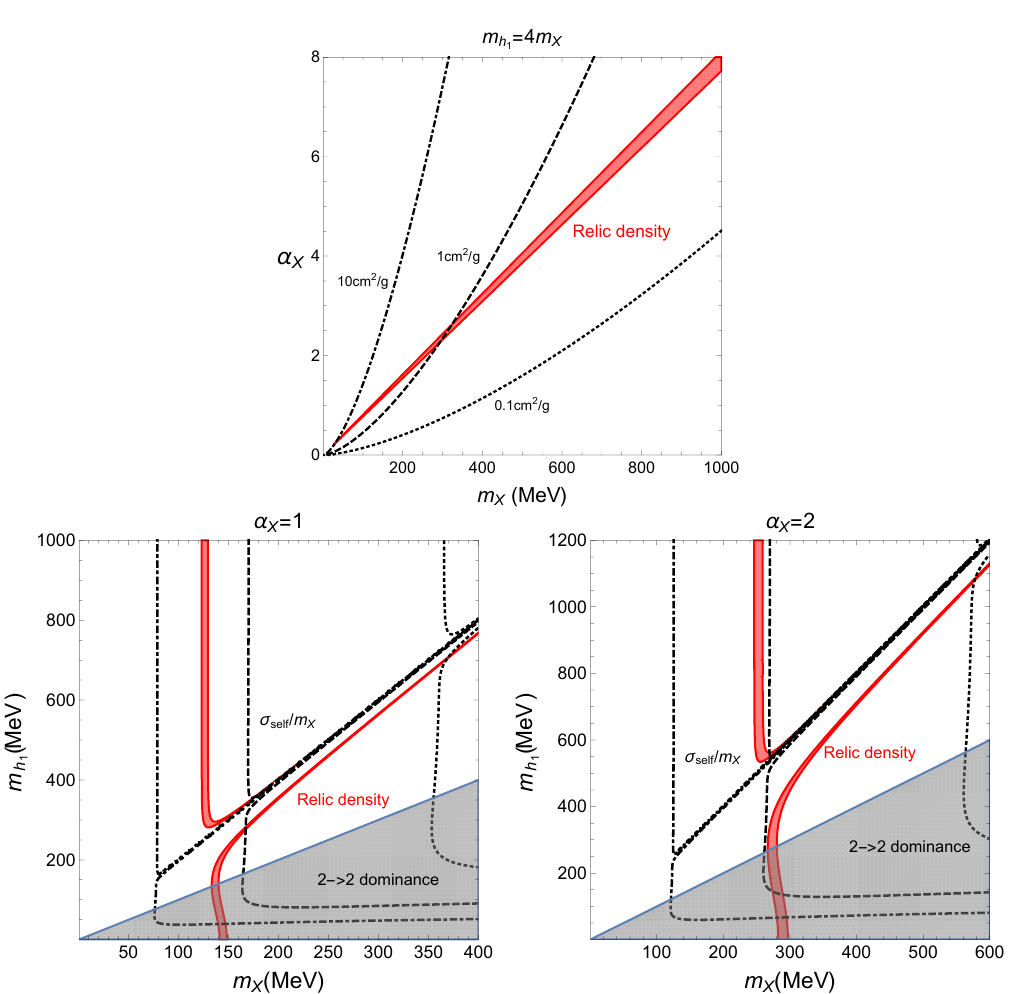
Figure 1 . The parameter space of vector SIMP dark matter in the m X vs. (cid:11) X (cid:17) g 2 or m h (bottom), when considering 3 ! 2 annihilation channels only. The Planck 3 (cid:27) measurement 1 of the relic density is show in red in all panels. Contours of the self-scattering cross section of (cid:27) self =m X = 0 : 1 ; 1 ; 10 cm 2 = g are shown in the dotted, dashed and dot-dashed curves, respectively. We have chosen m h = 4 m X on top and (cid:11) X = 1 ; 2 on bottom. The shaded gray regions in the 1 lower panels are where other 2 ! 2 channels dominate over 3 ! 2